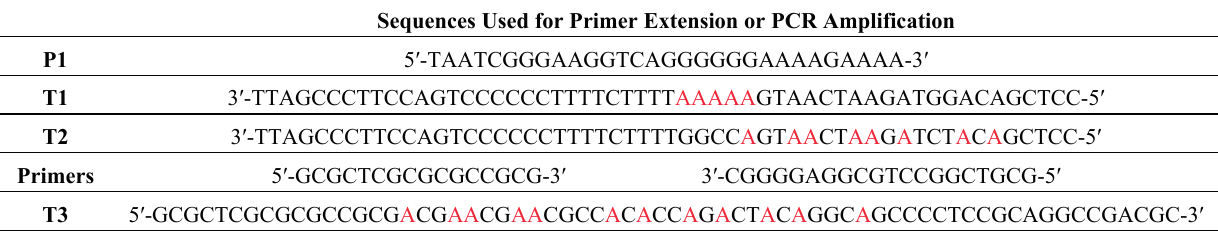
Table 1. Sequences of the primer and templates used in the primer extension assays. Red colored As indicate the position at which the polymerase must incorporate a modified